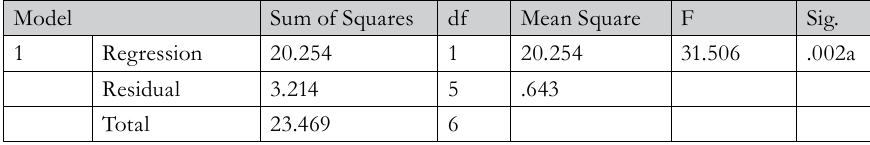
Tab. 7 – ANOVA b – Czech Republic. Source: own